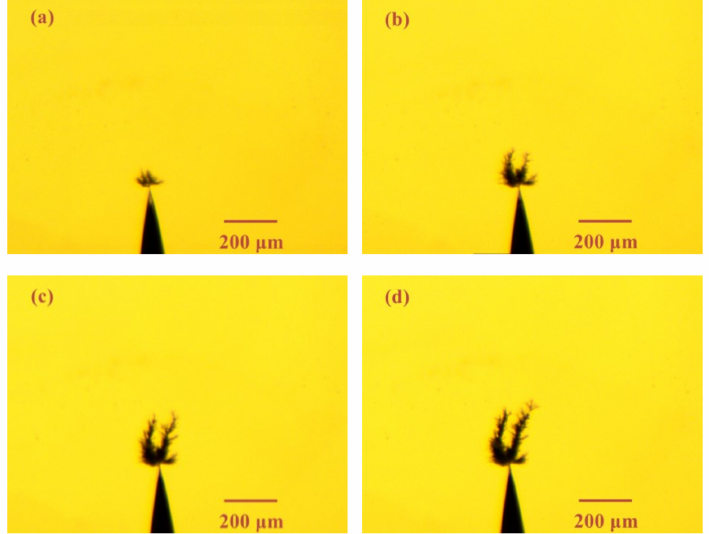
Figure 4. Electrical tree morphology in epoxy casting insulation sample with small air gap under 1 kHz / 8 kV bipolar square-wave voltage at time of ( a ) 1 min, ( b ) 5 min, ( c ) 10 min, ( d ) 15